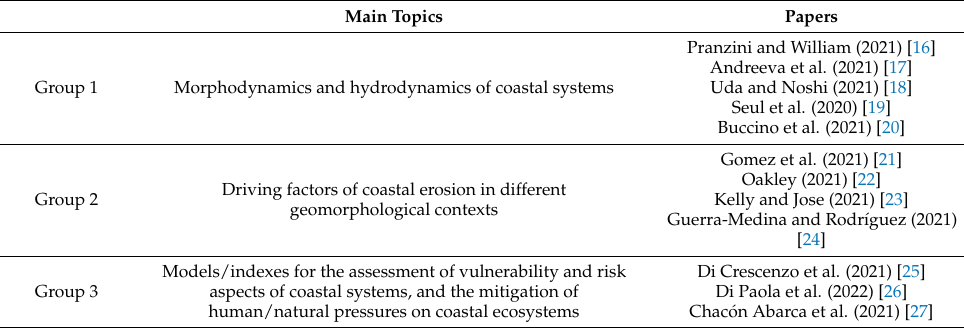
Table 1. Grouping of contributions according to major research topics